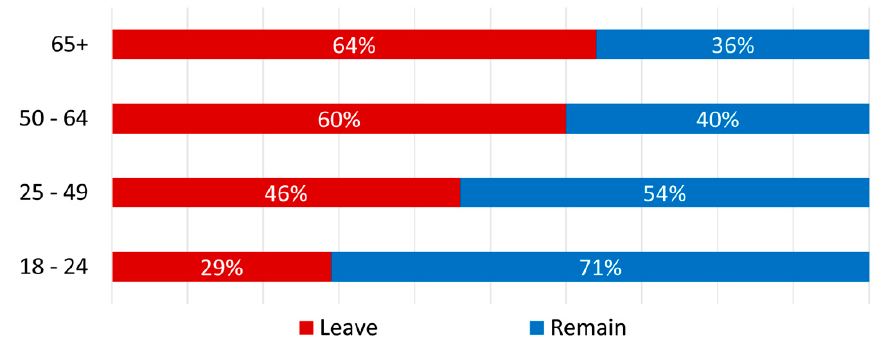
Figure 8. EU referendum votes by age (https://yougov.co.uk/news/2016/06/27/how-britain-voted/).